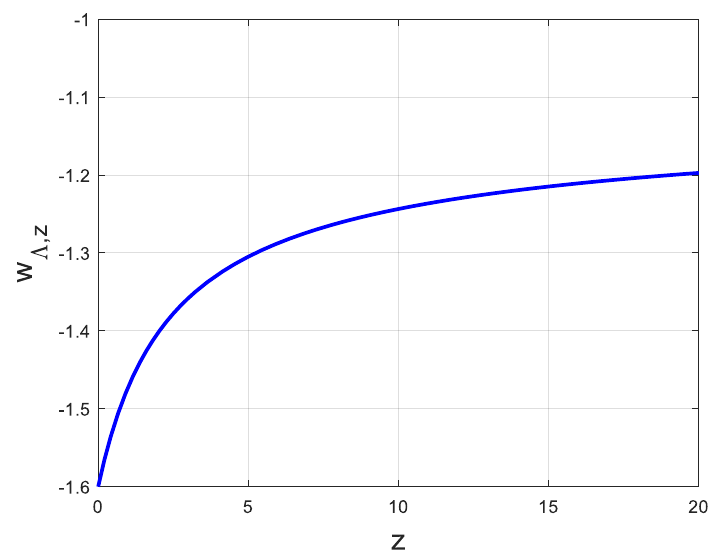
Figure 5. Equation of state parameter 𝑤 Λ,𝑧 vs. redshift 𝑧 .